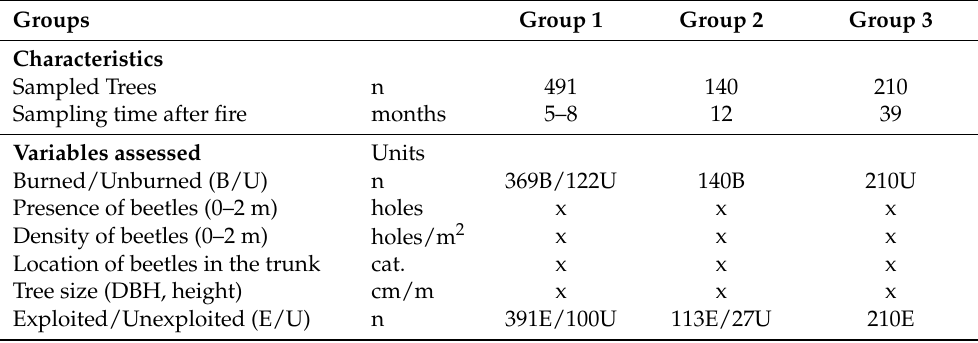
Figure 2. Ambrosia beetle holes and sawdust in the trunk of a burned cork oak tree: detailed view ( left ) and overview ( right ). Table 1. Summary of the main characteristics and data collected (x indicates data collection) in the three groups of trees surveyed in the current study, including a total of 841 cork oaks sampled (for details, see the subsections from Sections 2.2.1–2.2.3).